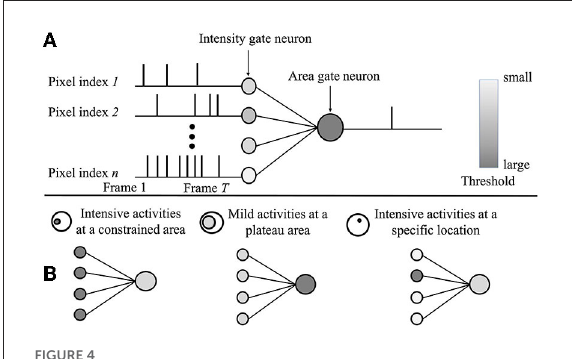
FIGURE4 (A) The spatial spiking neural network (SNN) computing mechanism. The event consists of T frames in total. (B) Examples of three spatial SNNs focus on different global feature detection.